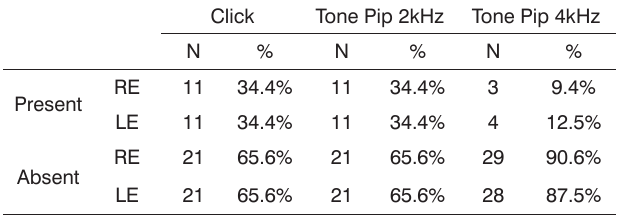
Table 2. Result of OAEs evoked by clicks and tone pips at 2,000